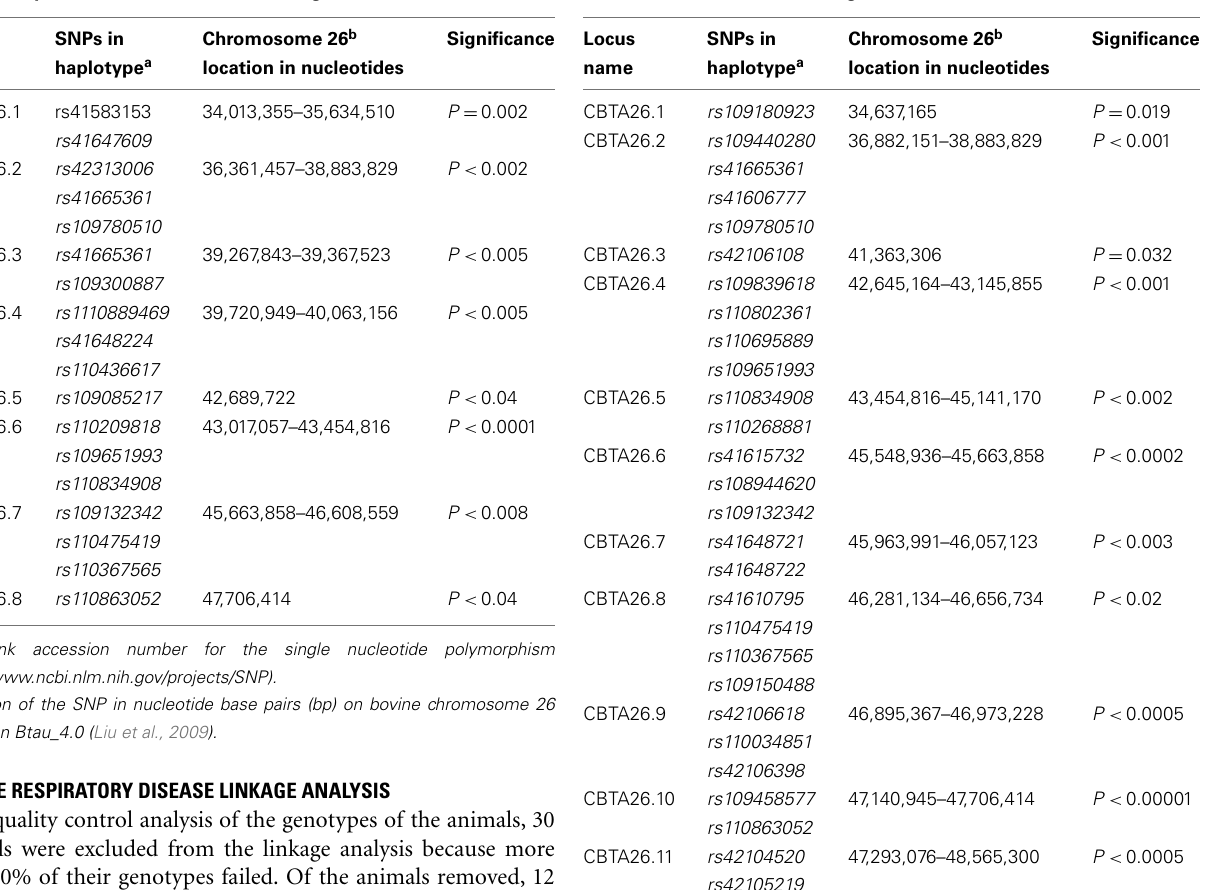
Table 3 | Haplotypes associated with dams of bovine viral diarrhea persistently infected calves on BTA26 using the allelic model.